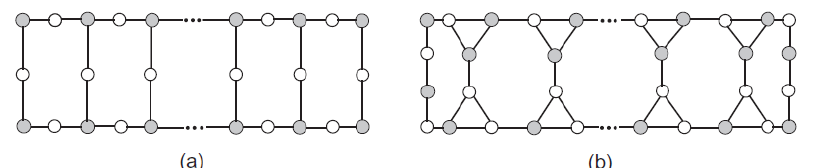
Figure 3. ( a ) Subdivision graph of the ladder graph L n ; ( b ) Line graph of the subdivision graph of the ladder graph L n